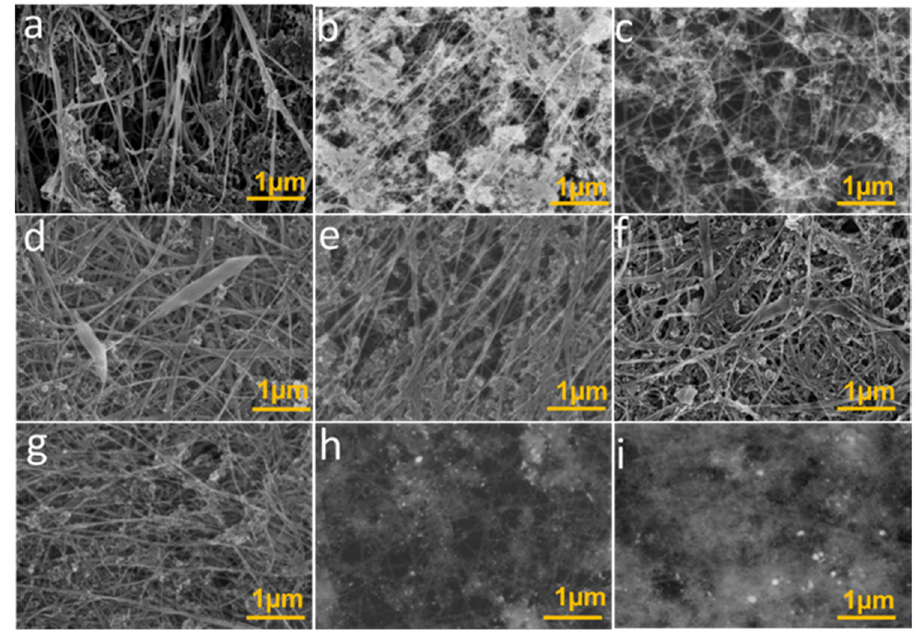
Figure 5: SEM micrographs of CNT fi lms with lower magni fi cation: ( a ) PCNT, ( b ) NC - 1, ( c ) NC - 2, ( d ) AC, ( e ) EC, ( f ) HC, ( g ) HNC - 2, ( h and i ) backscattered electron imaging of NC - 2 and HNC -